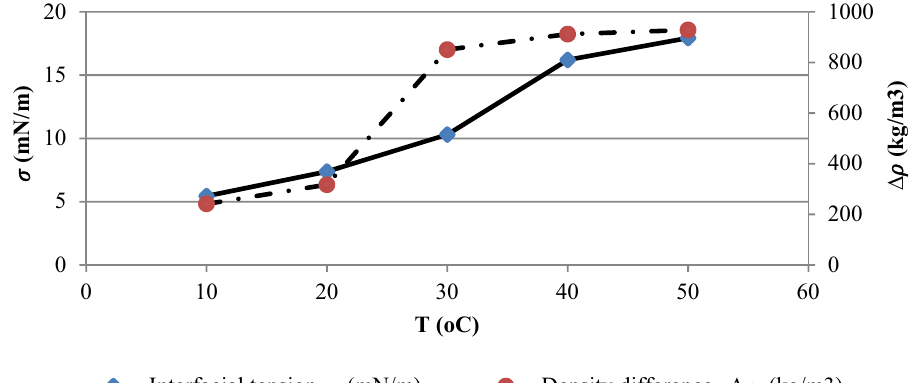
Fig. 7 Static interfacial tension of TEG in CO 2 environment as a function of temperature at 70 bars. The figure also shows the density difference of TEG–CO 2 mixtures as a function of tem- perature at the right-hand side of the